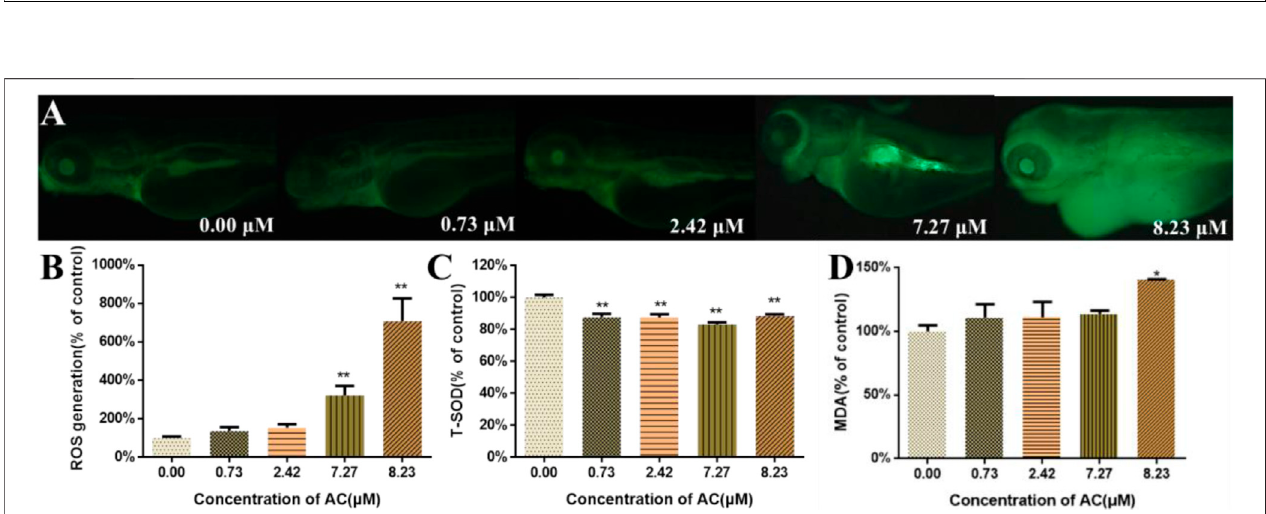
FIGURE5| ROS,T-SOD,andMDAmeasurement. (A) Imagesofzebra fi shlarvaesubjecttoROSassayin fl uorescence fi eldat96hpf. (B) ROSgenerationat96hpf ( n (cid:1) 10). (C) TheactivitiesofT-SODat96hpf( n (cid:1) 3,whichmeans3poolsof50larvae). (D) ThecontentofMDAat96hpf( n (cid:1) 3,whichmeans3poolsof50larvae).Values are expressed as mean ± SD. * p < 0.05 and ** p < 0.01 vs. control.